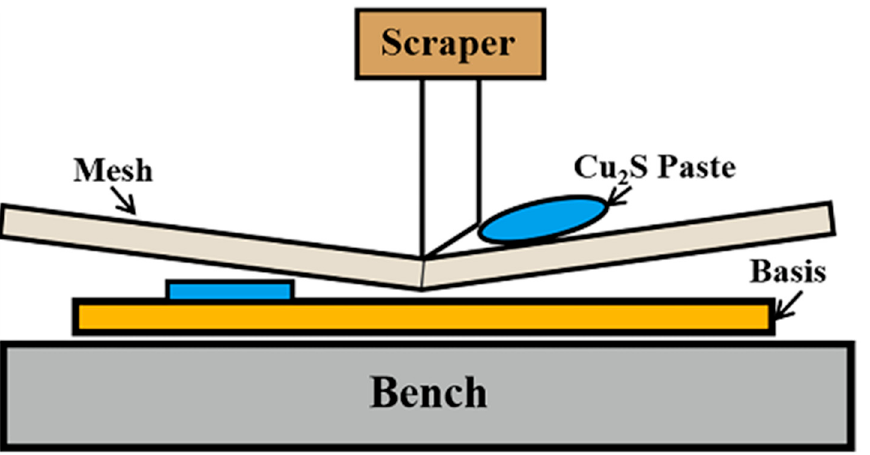
Figure 1. Screen printing diagram of Cu 2 S